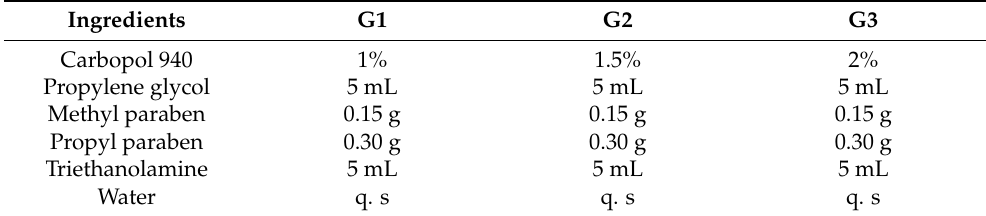
Table 4. Formulation of Carbopol gel.